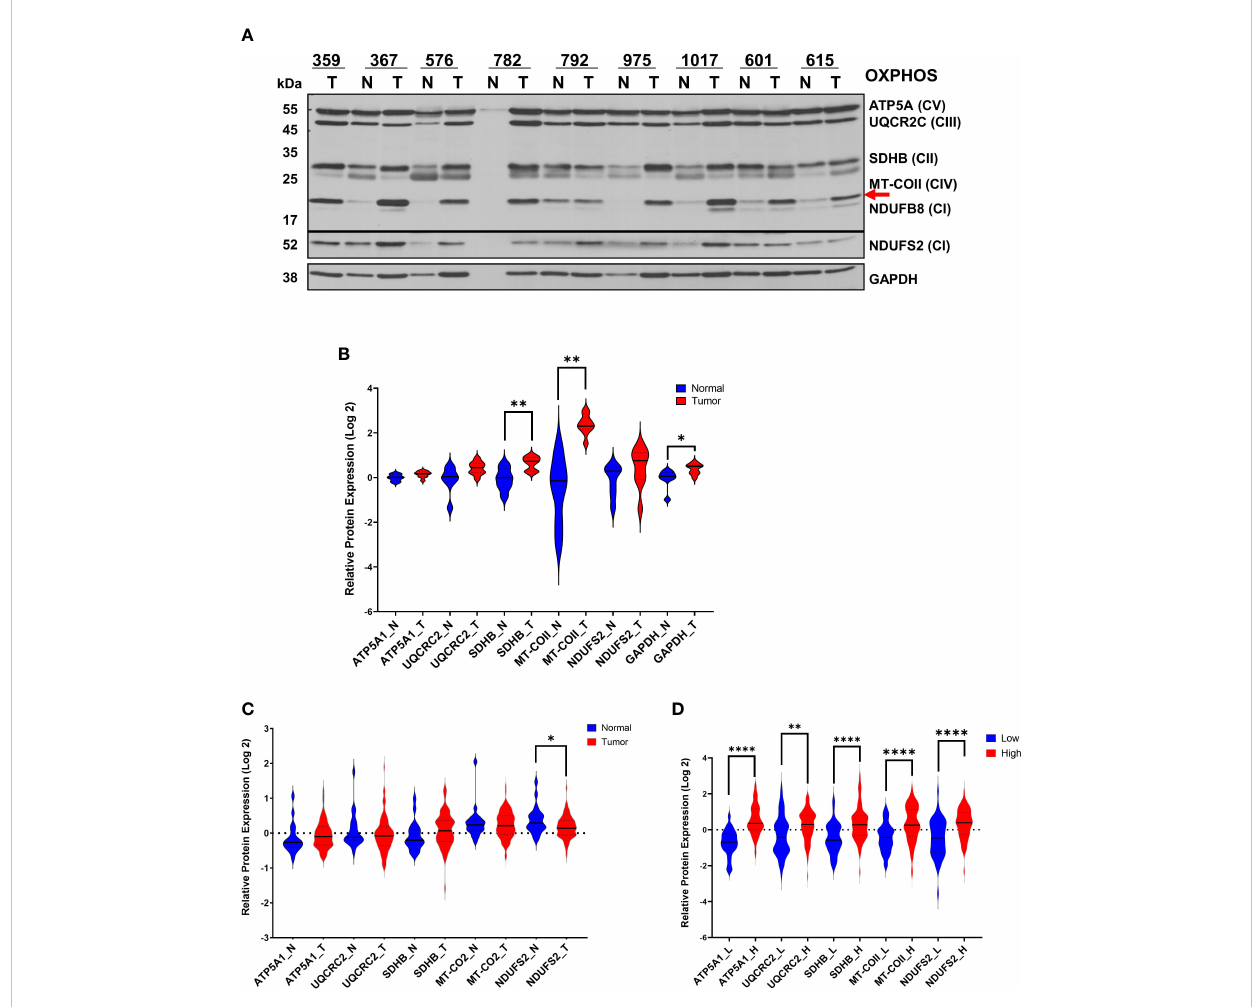
FIGURE 1 Modulation of OXPHOS subunit expression in ovarian cancer. (A) The expression of OXPHOS subunits, including ATP5A1 (CV; Complex V), UQCRC2 (CIII; Complex III), SDHB (CII, Complex II), MT-COII (CIV; Complex IV), NDUFB8 and NDUFS2 (CI; Complex I), and GAPDH were detected by immunoblotting in normal (N; blue) and ovarian tumor (T; red) biopsies. Only a tumor biopsy was available for patient 359. Approximately 20 m g of protein lysates obtained from normal and tumor tissues were separated by 12% SDS-PAGE, and the immunoblotting analyses were performed using antibodies shown on the left side. For patient 782, the normal tissue protein amount was extremely low, and it was not included in the quantitation. The red arrow shows the mt-encoded complex IV subunit, MT-COII. (B) Relative protein expression was quanti fi ed by normalizing the signal intensities of antibodies to protein loading and presented as violin graphs after conversion to log 2 values. (C) Log2 protein expression values of OXPHOS subunit expression determined by MS-based proteomics of 20 normal (N; blue) and 83 HGSOC ovarian biopsies (T) published by McDermott et al. [Log 2 values are taken from Supplemental Data in reference (45)] as part of the CPTAC. (D) Log2 OXPHOS subunit expression values for 53 low (L; blue) and 74 high (H; red) HGSOC tumors were reported by Gentric et al. [Log 2 values are taken from Supplemental Data in reference (7)] as part of the Curie cohort. For the statistical analysis, unpaired Welch ’ s t-test was used, and the P values ≤ 0.05 were represented as (*), ≤ 0.01 (**) and ≤ 0.0001